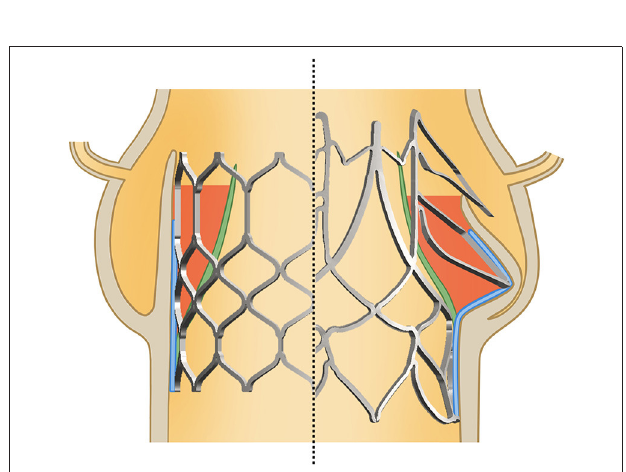
FIGURE 14 | Difference between a conventional cylindrical TAVR and the SAT design: by skirting the supra-annular anchorage arms a spaceous neo-sinus is created between skirt (blue) and prosthesis leaflet (green) intended to facilitate sufficient vortex formation for the prevention of thrombus. This is opposed by the relatively narrow space of the neo-sinuses in cylindrical